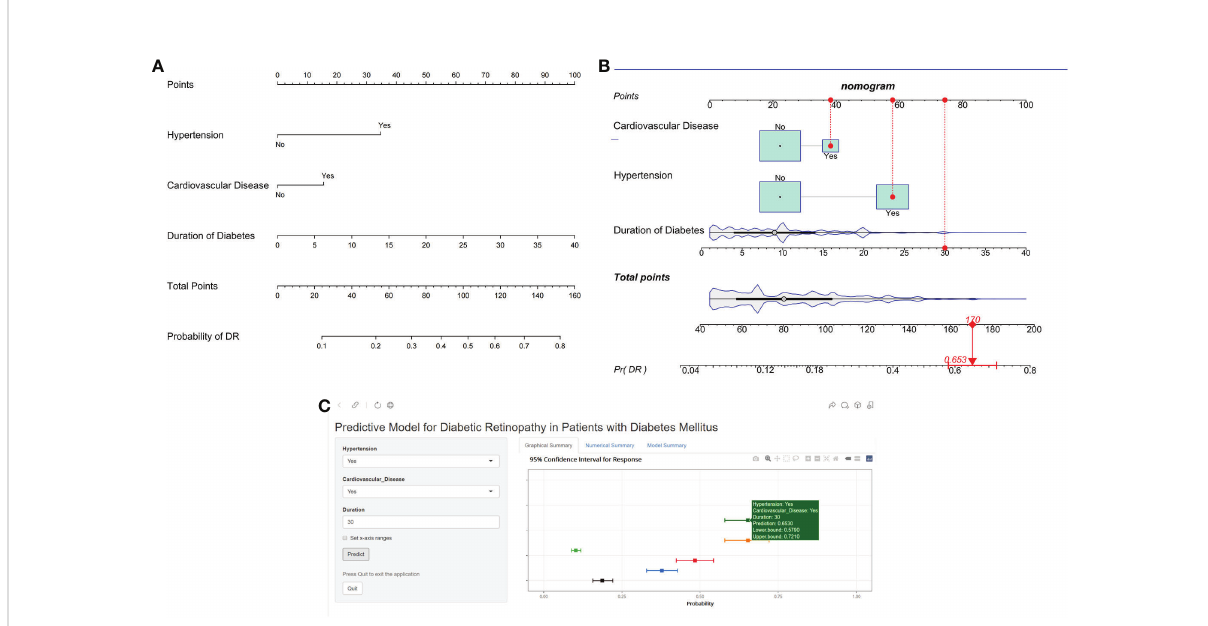
FIGURE 2 Nomogram identifying retinopathy in patients with DM. (A) Risk nomogram for identifying retinopathy in patients with DM. (B) One patient from our study is shown as an example (presented in red). (C) An example of Nomogram to identifying retinopathy in patients with DM Via a Link.